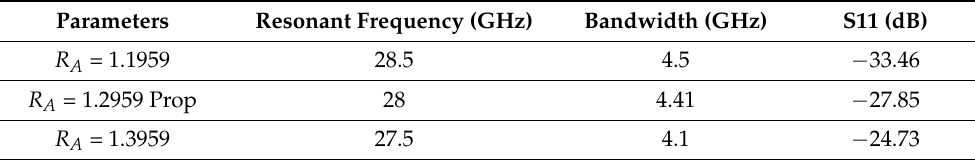
Figure 5. Reflection coefficient concerning R A . Table 3. Antenna simulation results of patch parameter ( R A ).